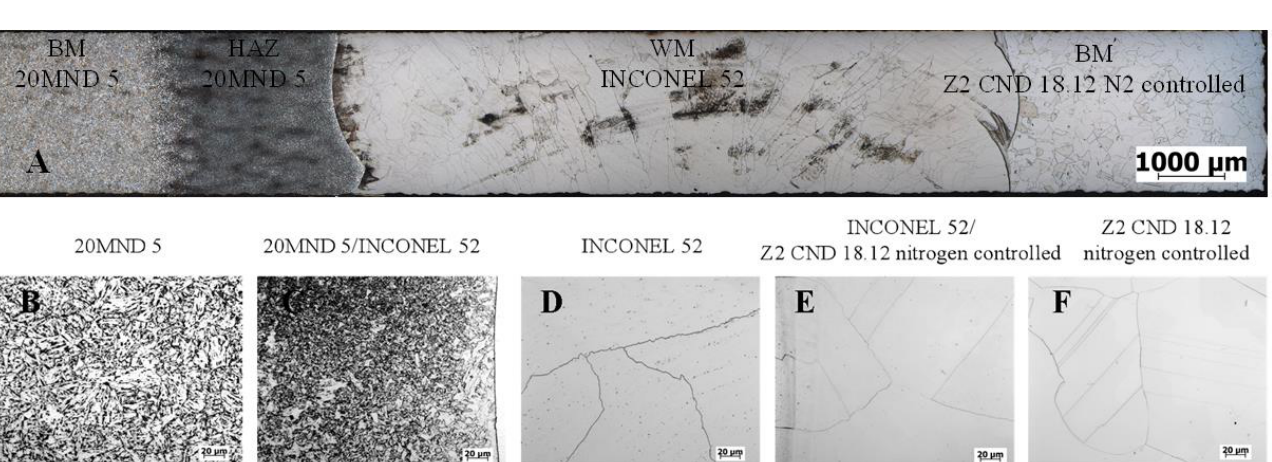
Figure 8. The tensile test of an SF tensile specimen.